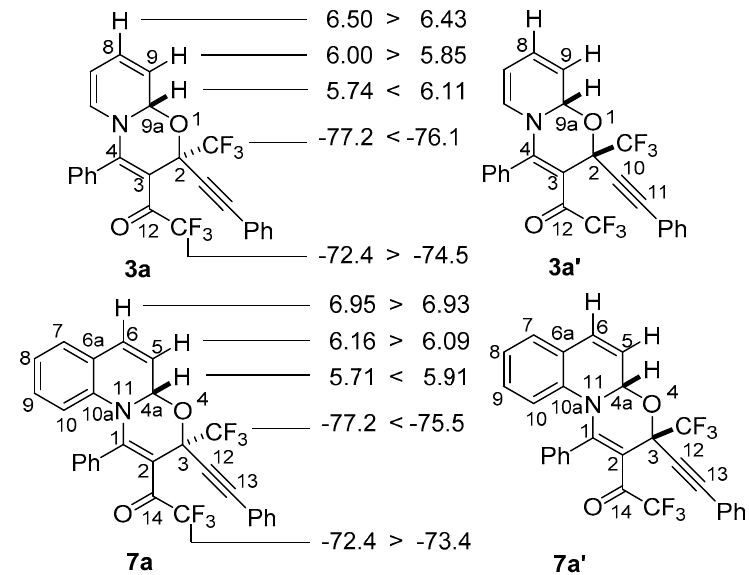
Figure 2. Comparison of characteristic values of chemical shifts of diastereomers of 3a in 1 H- and 19 F-NMR spectra with the corresponding quinoline derivative 7a .